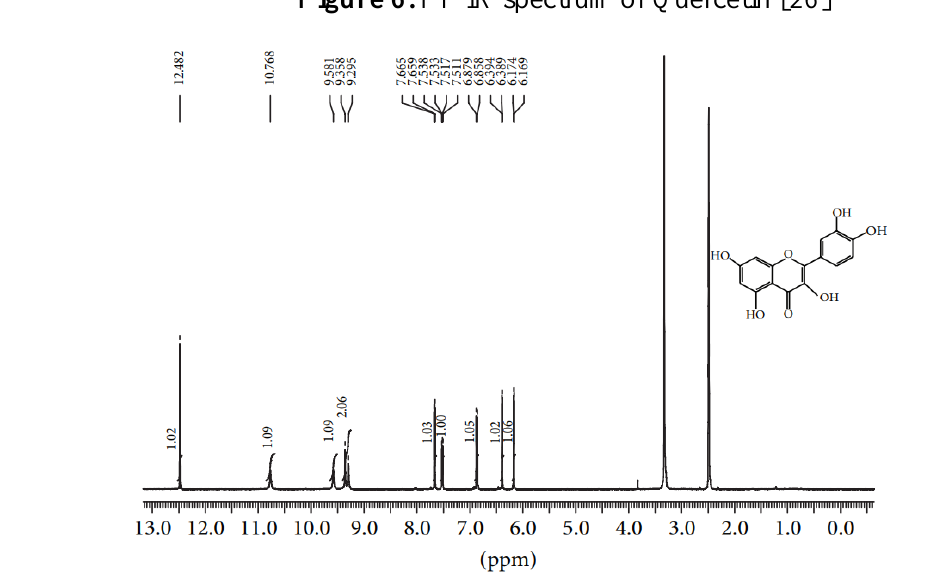
Figure 6. FT-IR spectrum of Quercetin [26]